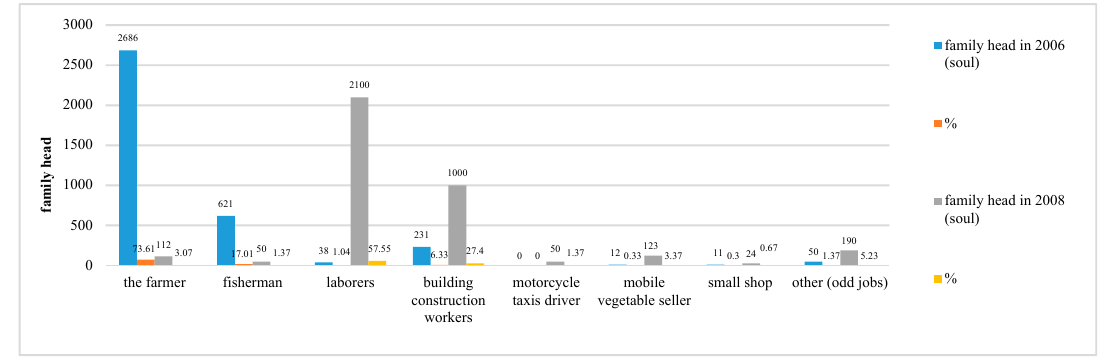
Figure 6. Orientation of the livelihoods of local communities in 2006–2008. Source: Processed data from village monograph data, 2006–2008.